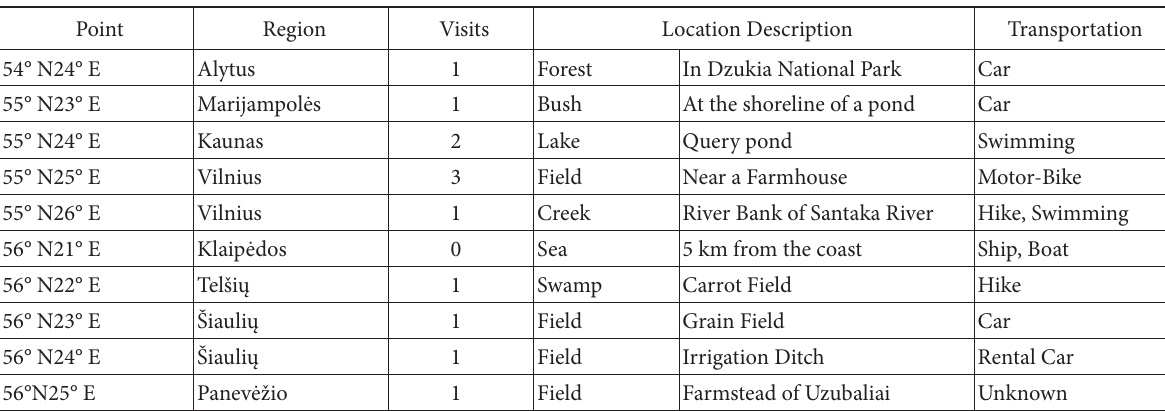
Table 2. Details of the 10 Confluence Points in